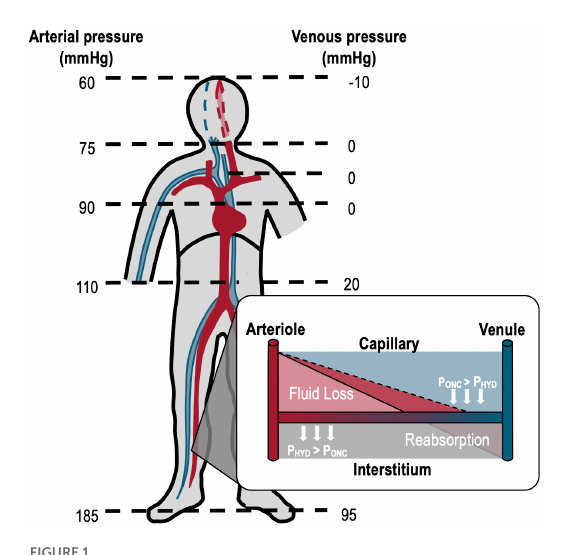
FIGURE1 Effects of gravity on arterial and venous pressures in an upright, motionless human. Orthostatic arterial and venous pressures are shown on the left and right, respectively. With orthostasis, arterial and venous pressures above heart level decrease while pressures below the heart increase due to the gravitational redistribution of blood (venous pooling). The white inset diagram shows Starling forces of hydrostatic pressure (P HYD , light red shading; generated by the circulating blood pressure, which force fluid out of the vessel) and oncotic pressure (P ONC , solid line; generated by plasma proteins, which promote fluid reabsorption) at the capillaries. In orthostasis, the increased lower extremity hydrostatic pressure (dark red shading, dashed line) promotes fluid loss at the capillaries and thus the accumulation of edema in the tissue. The combined venous pooling and capillary filtration reduce the effective circulating blood volume compromising cardiovascular control. Adapted from Hainsworth et al.